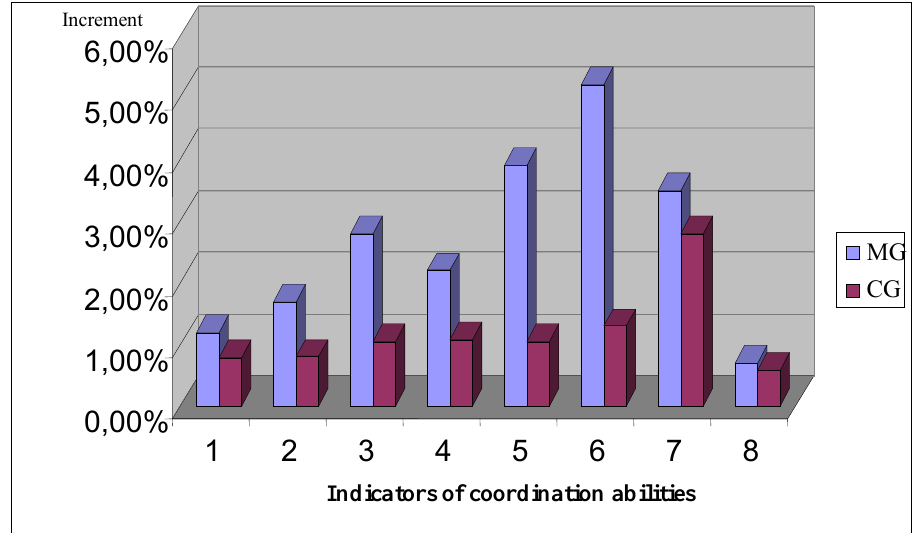
Fig.1. Dynamic of increment of junior sportsmen’s coordination